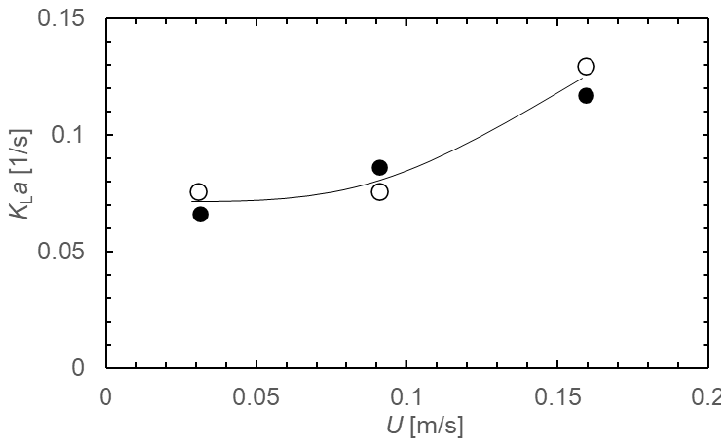
Figure 9. Effect of flow rate on overall mass transfer capacity coefficient ( K L a ) by a piezo micropump (●) or syringe pump ( ○